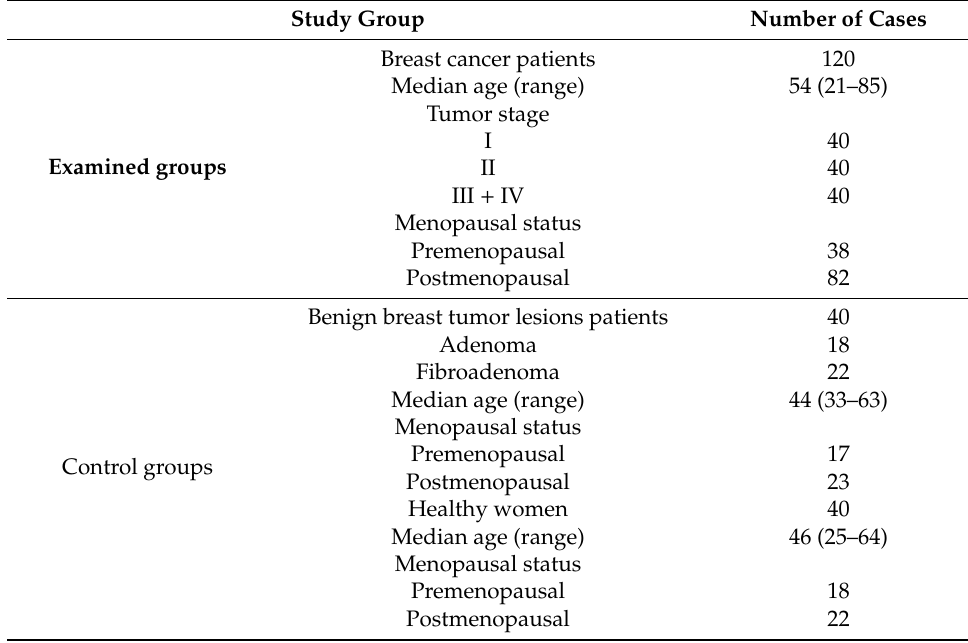
Table 1. Characteristics of studied groups, breast cancer (BC) patients and control